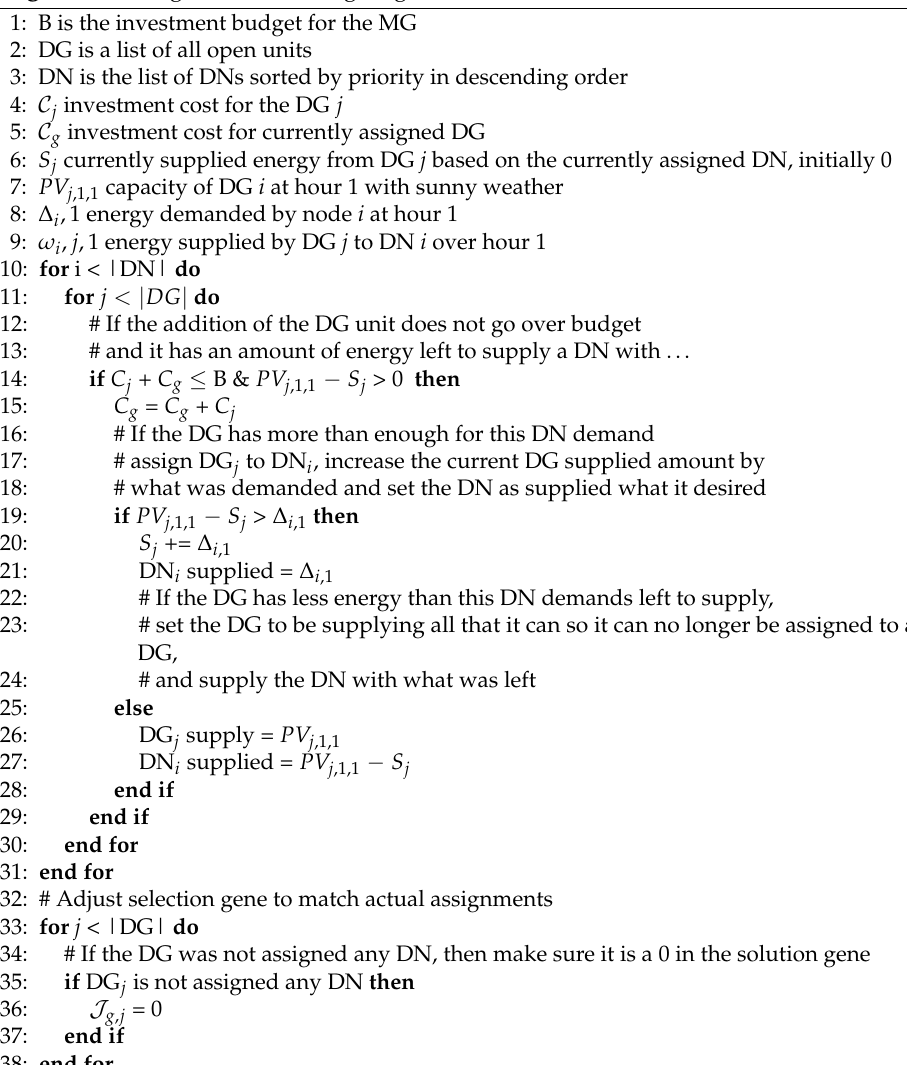
Algorithm 1 Algorithm for assigning a DG to a